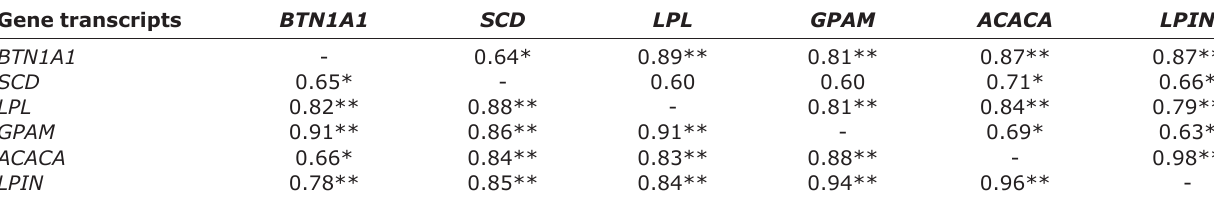
Table-6: Correlation coefficients among relative expression of major milk lipogenic genes day 60 pp in Jafarabadi buffaloes (above diagonal) and Surti buffaloes (below diagonal). Gene transcripts